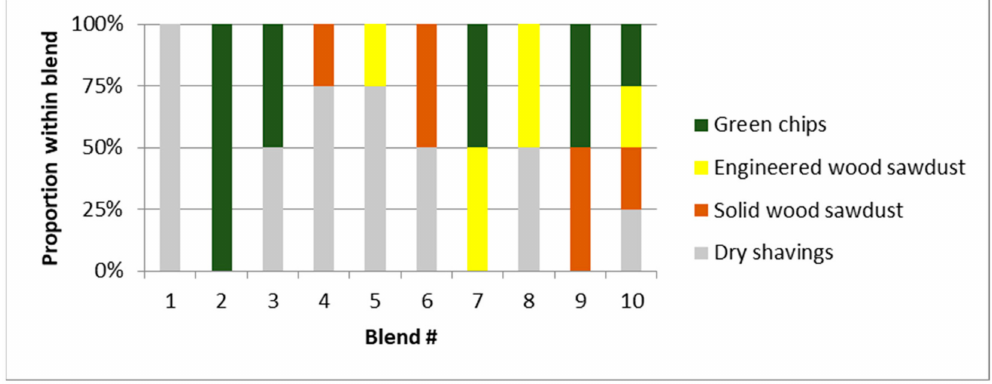
Figure 2. Proportion of sources of residues within blends (in